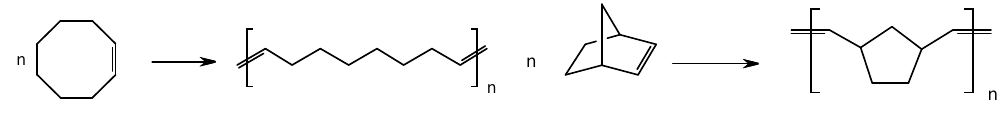
Figure 4. ROMP of cyclooctene over 4.5 /SiO 2 (stars), 4.5 /MCM-41(squares), 4.5 /SBA-15 d = 6.3 nm (circles), 4.5 /SBA-15 d = 11.1 nm (diamonds). Cyclohexane, T = 13 °C, molar ratio cyclooctene/Ru = 500, c 0cyclooctene = 0.6 mol/L, numbers at individual experimental points give M w of polymer in